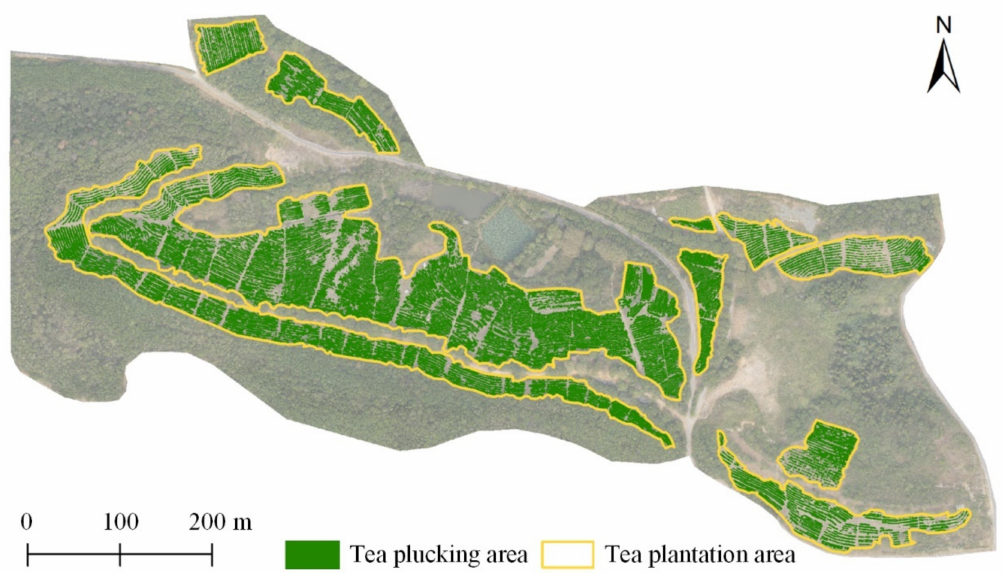
Figure 16. Illustration of tea plantation areas (from manual interpretation) and tea plucking areas in the Huashan Tea